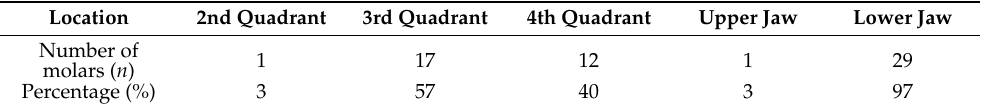
Table 3. Distribution of ankylosis based on location.